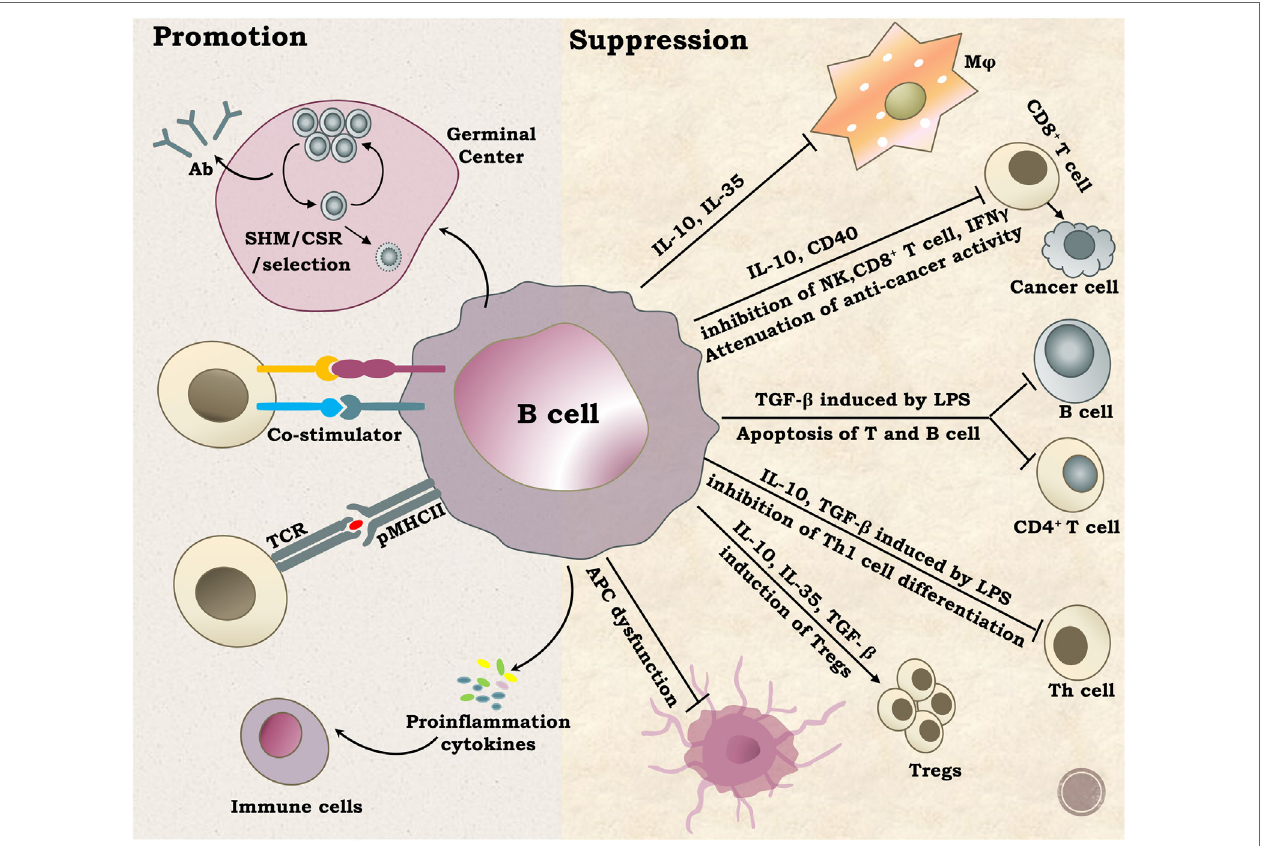
FiGURe 2 | Functions of B cells. B lymphocytes perform diverse and complex roles in vivo mainly through promotion or suppression of immune responses. The well-known function of B cells is antibody production by plasma cells after SHM selection and CSR. B cells can also activate other immune cells by providing co-stimulation signals, serving as antigen-presenting cells or secreting multiple proinflammation cytokines, such as IL2, IL4, IL6, TNF- α , and INF- γ . On the other hand, B cells can suppress immune responses by regulating certain types of immune cells through multiple ways. Abbreviations: SHM, somatic hypermutation; CSR, class switch recombination; Ab,